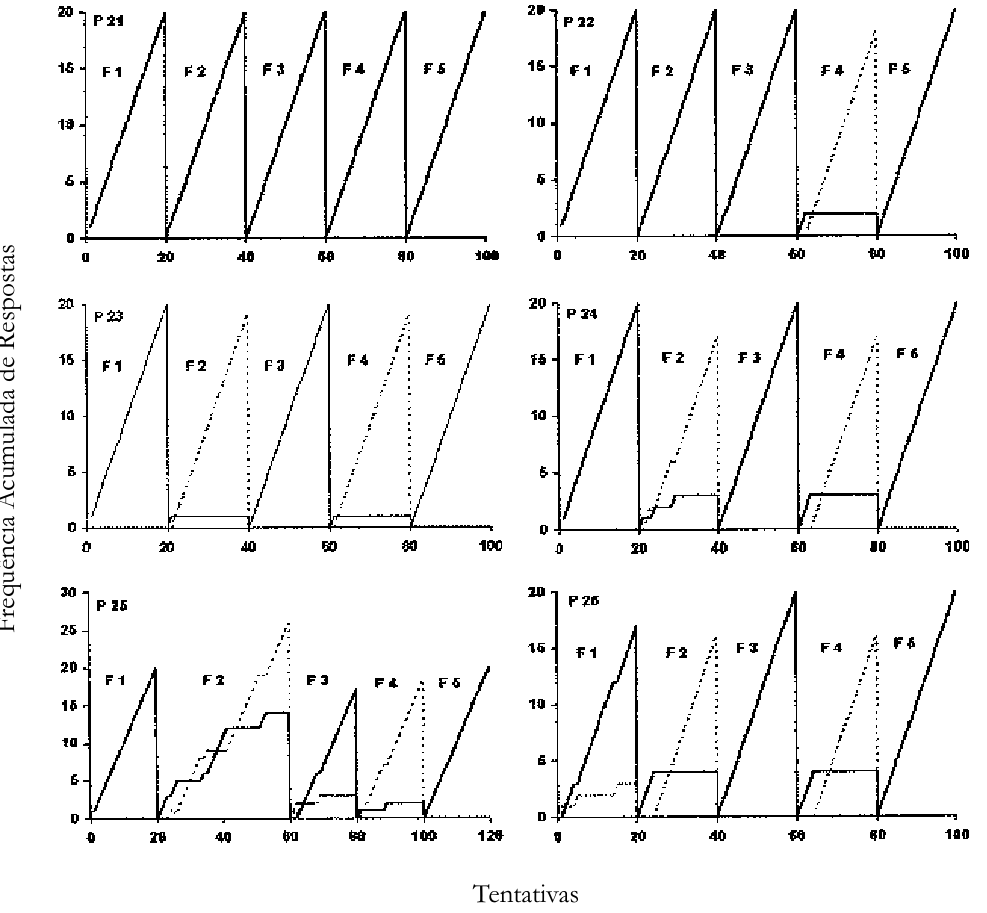
Figura 2. Freq(cid:252)Œncia acumulada de respostas de seguimento de instru(cid:231)ıes (linha s(cid:243)lida) e nªo seguimento de instru(cid:231)ıes (linha tracejada), para cada participante (P) da Condi(cid:231)ªo II, durante cada fase (F) experimental. Quebras na curva acumulada indicam mudan(cid:231)as de fase. As Fases 1, 2 e 3 eram iniciadas com instru(cid:231)ıes que correspondiam (cid:224)s contingŒncias. Nas Fases 2 e 4, as instru(cid:231)ıes tornavam-se discrepantes das contingŒncias. O observador estava presente na